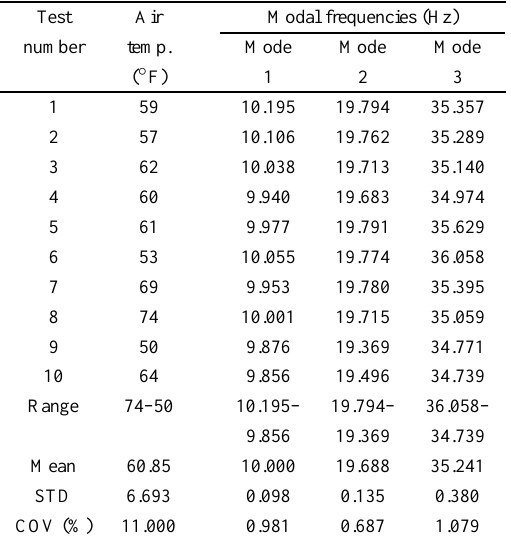
Variation of modal frequencies of field bridge, with simulated damage, at above-freezing temperatures